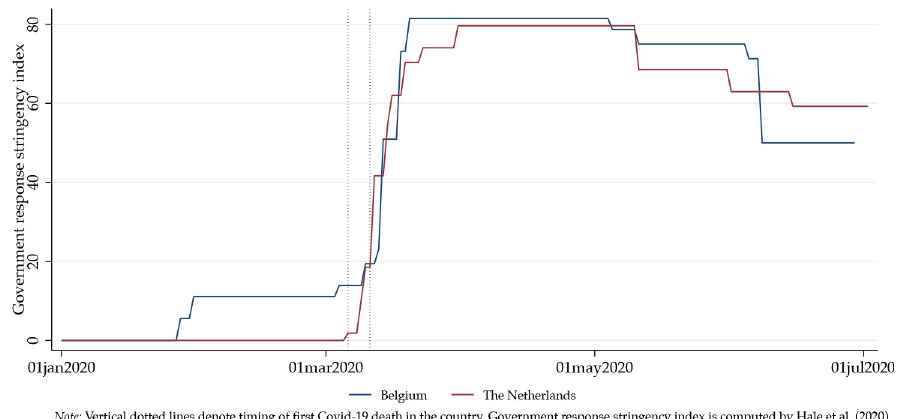
Fig 1. Stringency government response in The Netherlands and